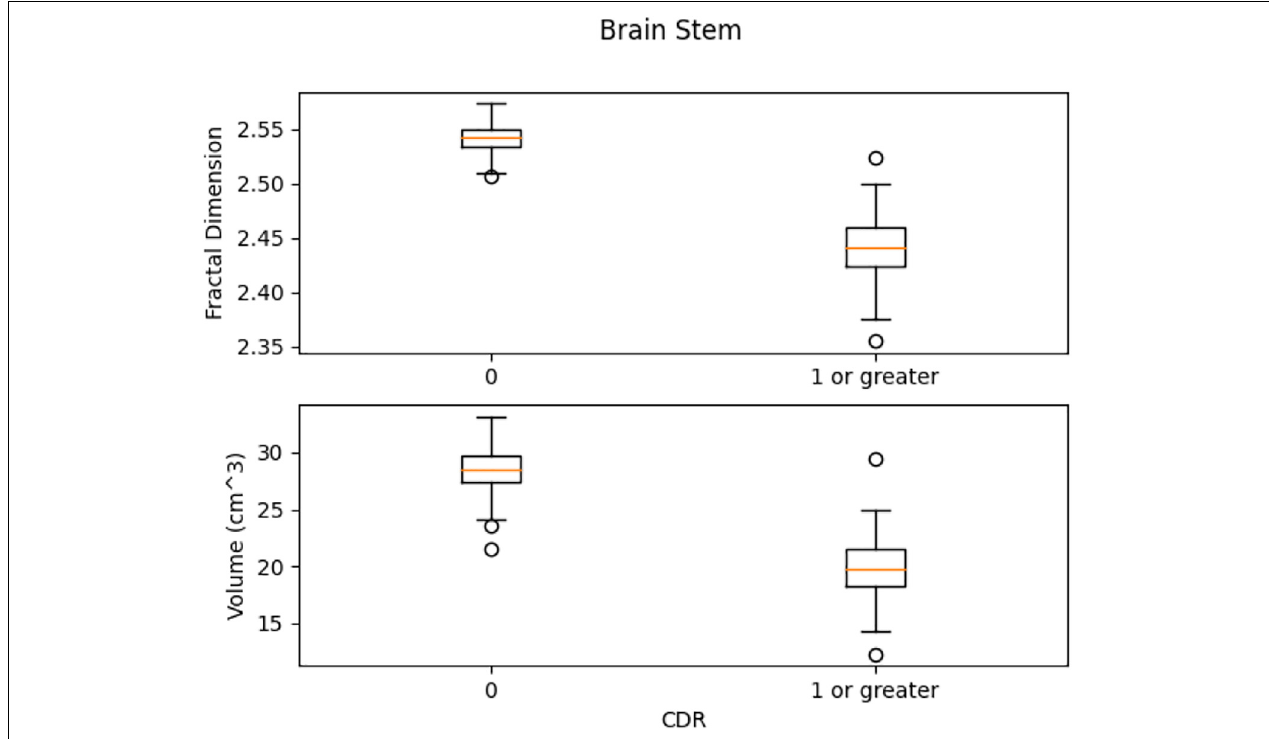
FIGURE 13 | Comparison of the distribution of health vs. control group. There is a slight overlap of the two classes in both features.